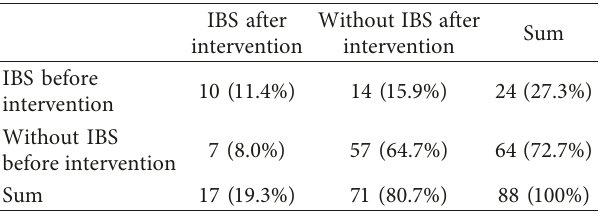
Table 2: Number (proportion) of subjects with irritable bowel syndrome (IBS) before and after the weight loss